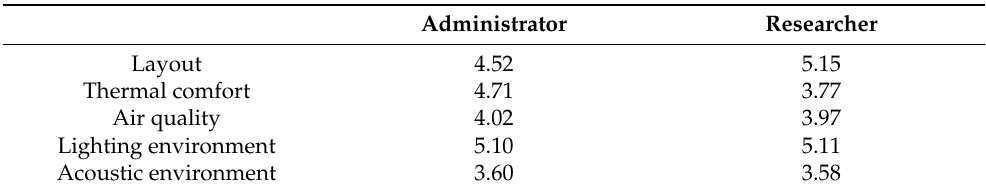
Table 5. Respondents’ perception of satisfaction with indoor environment quality (IEQ) items (Likert 7-point scale).